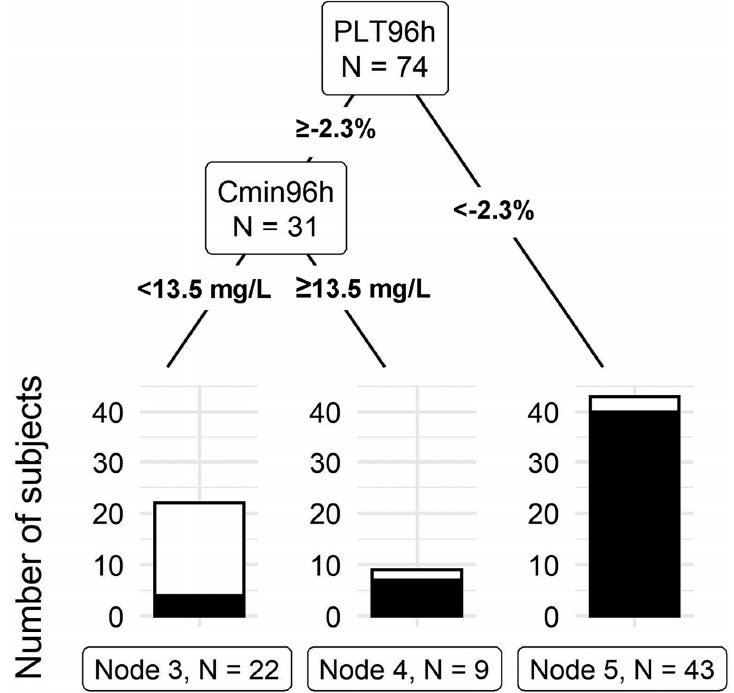
Figure 3. Classification tree for thrombocytopenia prediction. PLT96h: Platelet change from the baseline at 96 h after the initial dose. Cmin96 h: linezolid total concentration at 96 h after the initial dose (Takahashi, S. et al., 2021)